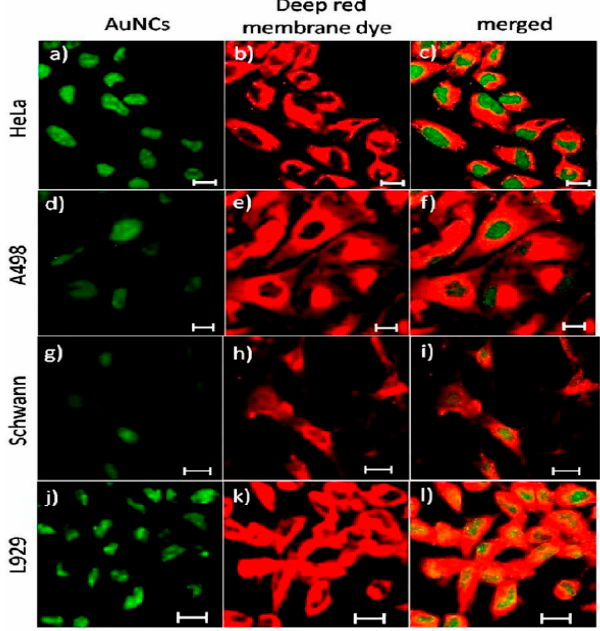
Figure 6. Confocal laser scanning microscope images of four different cell lines after treatment with green emitting AuNCs ( λ em = 510 nm); deep red plasma membrane dye exhibits red emission ( λ em = 633 nm), which is used as a reference for cell membrane staining. ( a − c ) Images of Au NCs, deep red plasma membrane dye, and their merged images of HeLa cells, respectively. ( d − f ) Images of A498 cells; ( g − i ) images of Schwann cells; ( j − l ) images of L929 cells (scale bar corresponds to 10 μ m) (Copyright Ref [76], American Chemical Society).